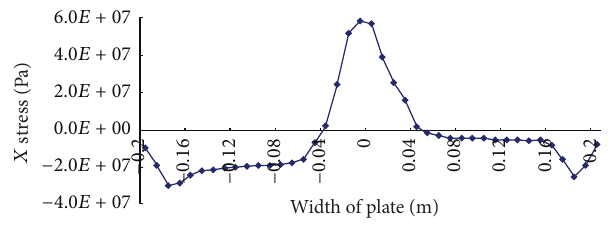
Figure 5: The 𝑋 stress in width of plate.